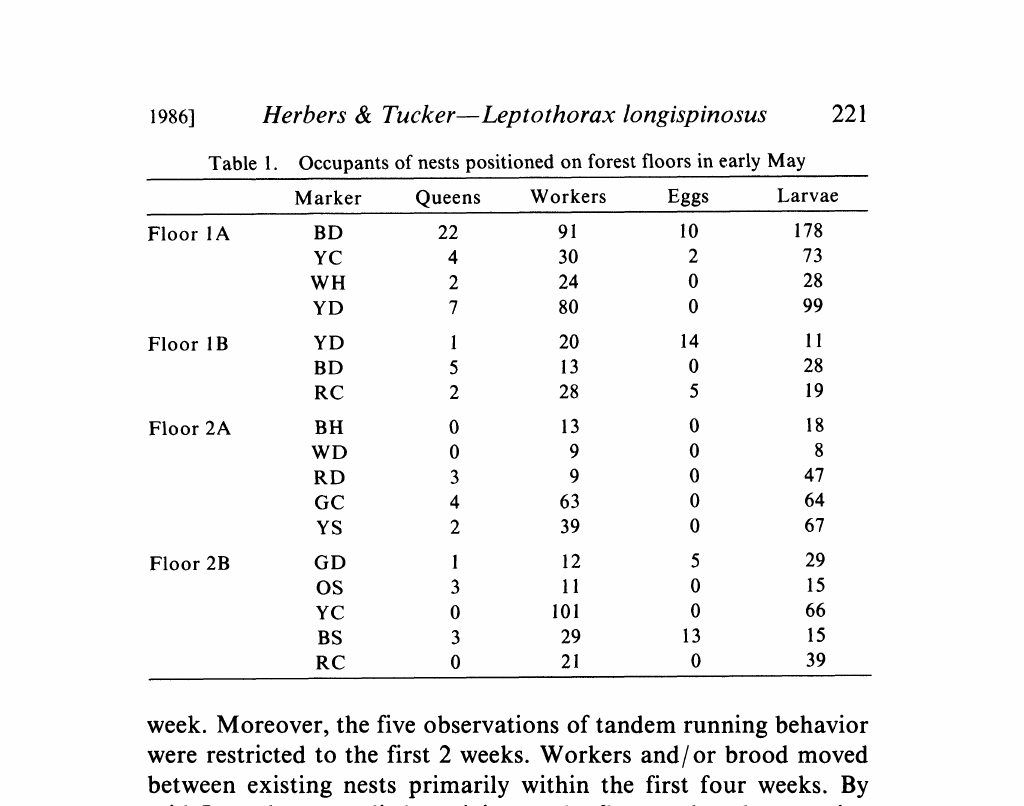
Table 1. Occupants of nests positioned on forest floors in early